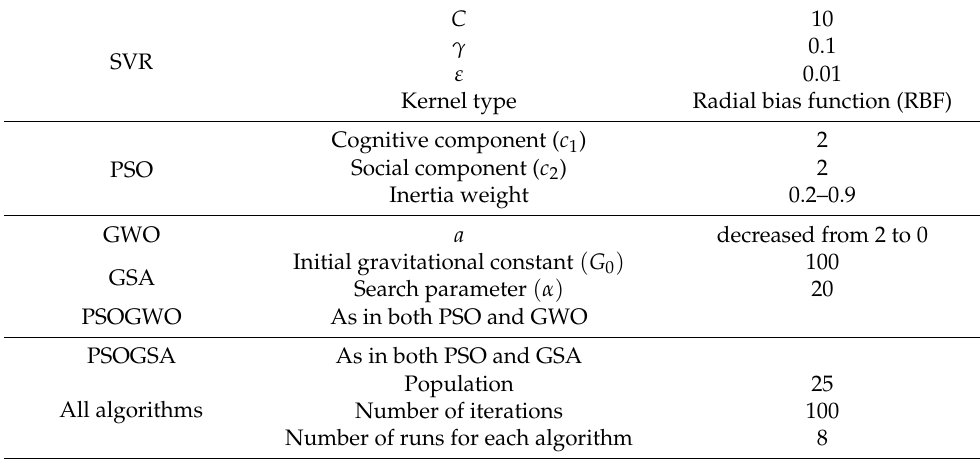
Table 2. Parameters setting of each optimization